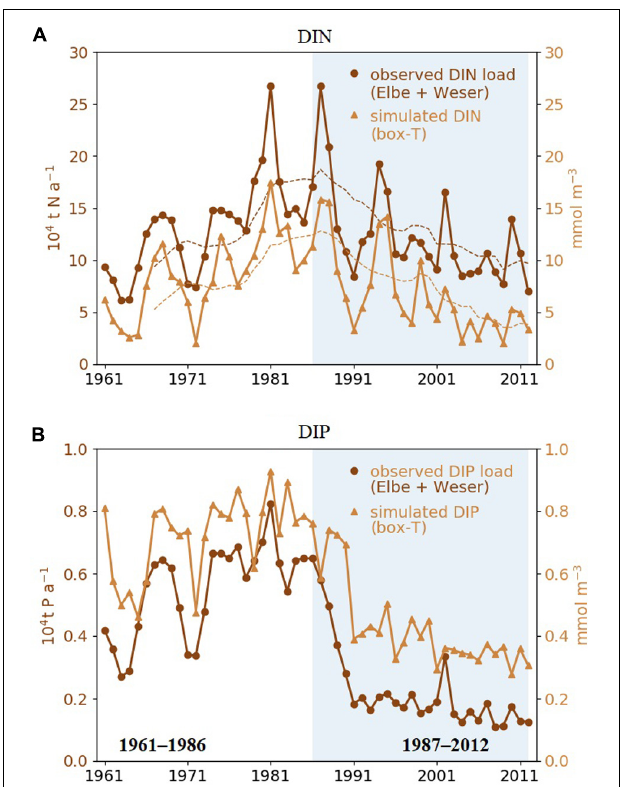
FIGURE 4 | (A) Simulated annual mean DIN concentration averaged over area “T” shown in Figure 1 (yellow triangles) and measured annual total DIN loads of rivers Elbe and Weser (brown circles). Dashed lines are 7-year running means. (B) Same as panel (A) , but for DIP. The recent period (1987–2012) are highlighted by shaded